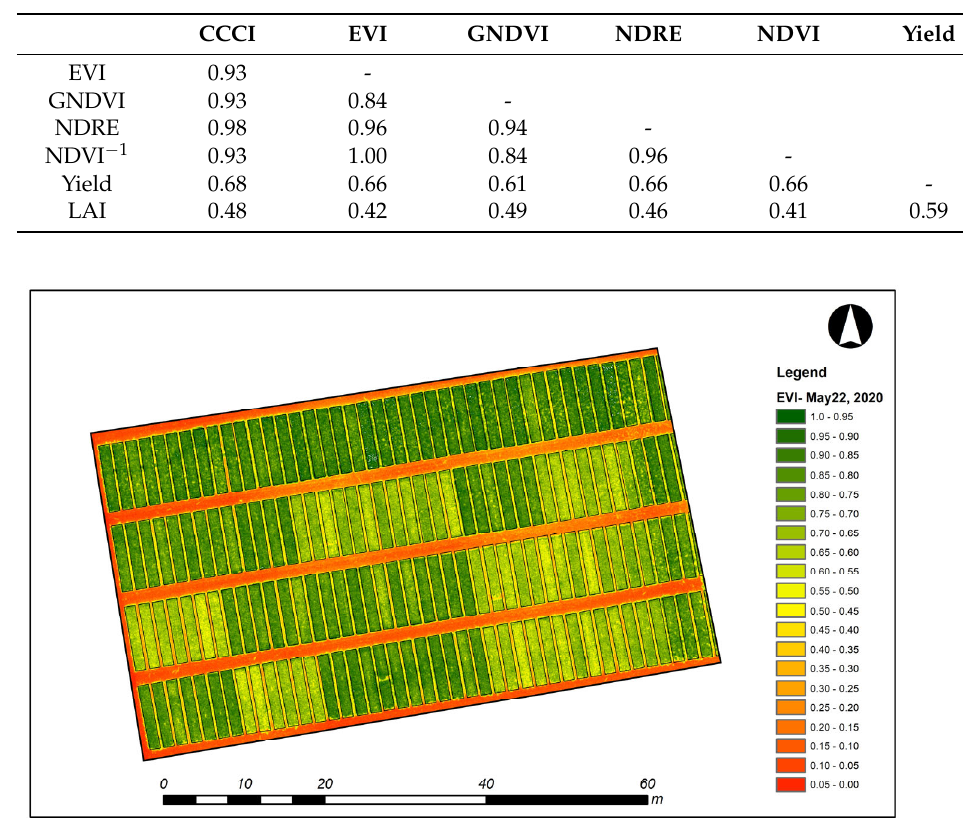
Figure 10. Visualization of EVI index depending on genotypes, sulfur and nitrogen fertilization. Table 9. Simple correlation coefficients between selected vegetation indices and the yield of hypo ‐ allergenic wheat grain (22 May 2020).